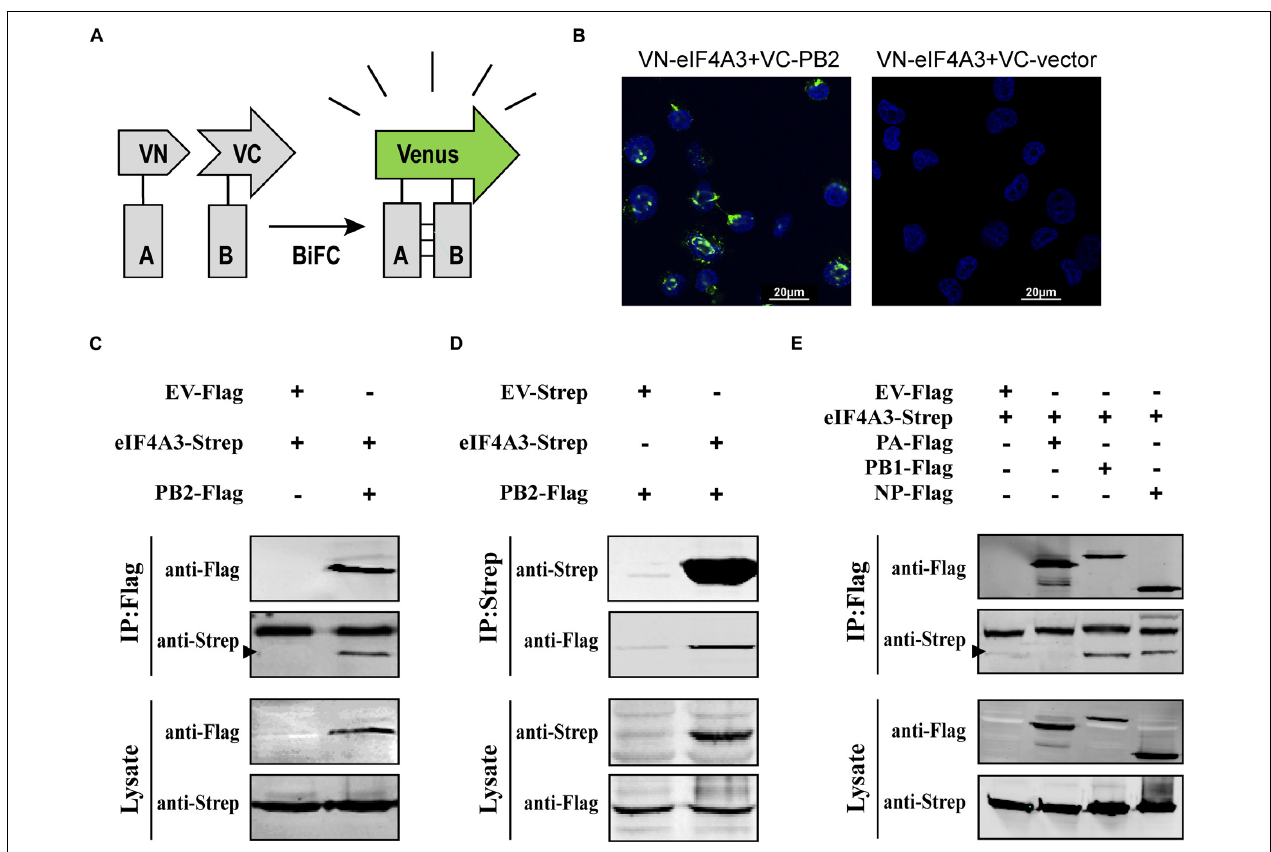
FIGURE 2 | eIF4A3 interacts with AIV PB2 and other subunits of viral polymerase in mammalian cells. (A) Schematic representation of BiFC analysis. Gray rectangle A and B represent a pair of proteins detected by BiFC. VN and VC represent the N-terminal fragment (residues 1–173) and C-terminal fragment (residues 174–239) of Venus protein, respectively. (B) BiFC assay for detecting interaction between PB2 and eIF4A3. HEK-293T cells were transiently transfected with indicated plasmids and incubated for 24 h. Fluorescence emission and brightfield were visualized. (C,D) Co-immunoprecipitation assays were performed with FLAG-tagged PB2 and Strep-tagged eIF4A3. Strep-tagged eIF4A3 or Strep-tagged empty vector was co-transfected in HEK-293T cells with Flag-tagged PB2 or Flag-tagged empty vector. After 24 h, cells were lysed followed by immunoprecipitation (IP) and western blot analyses. The arrow indicates the position of immunoblot. (E)